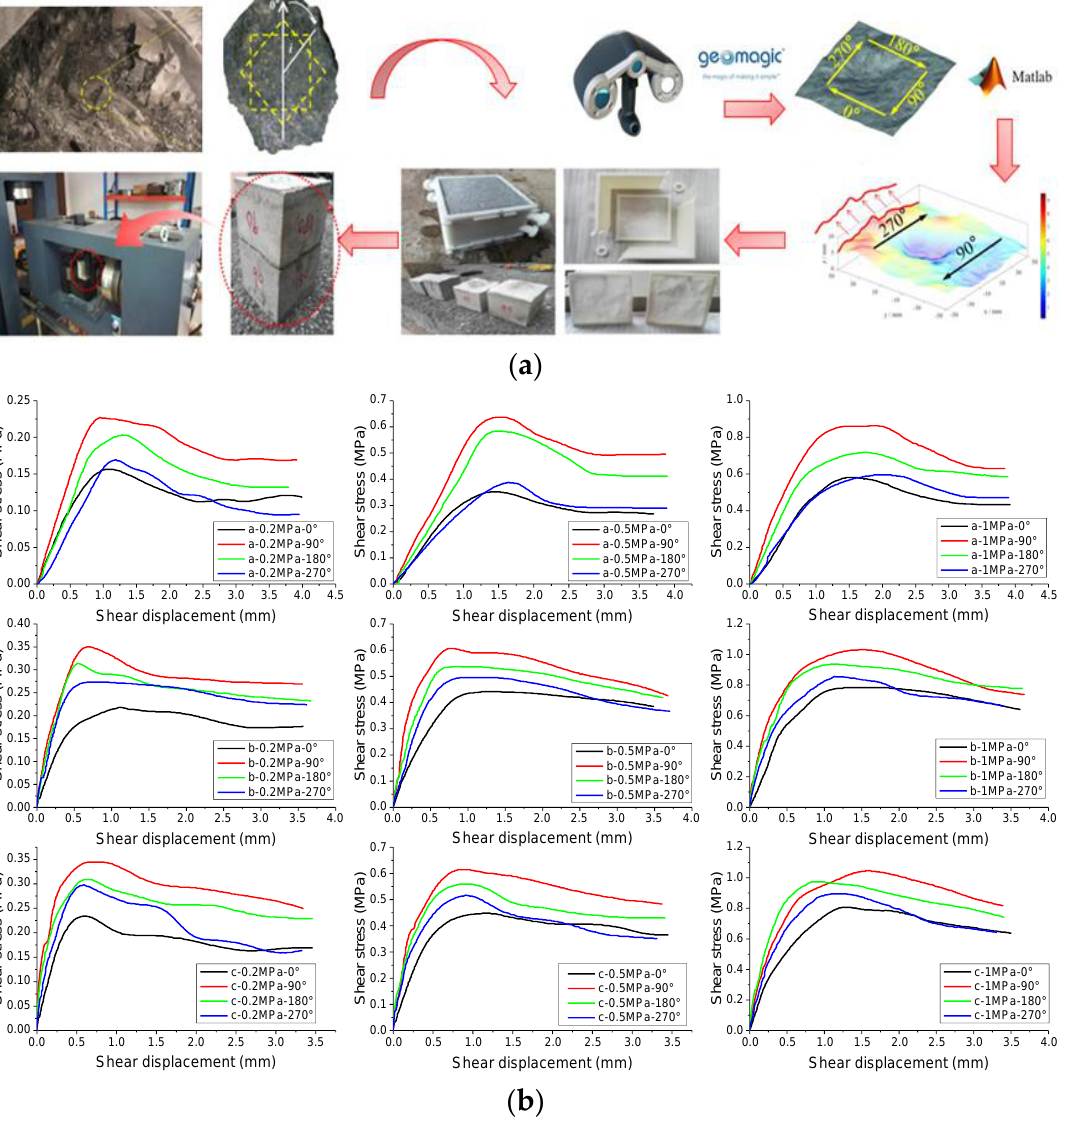
Figure 3. Preparation process and shear test results of joint samples, ( a ) Sample-making process, ( b ) Shear stress-shear displacement curves [69]. Table 1. Ingredient proportions of artificial joints samples